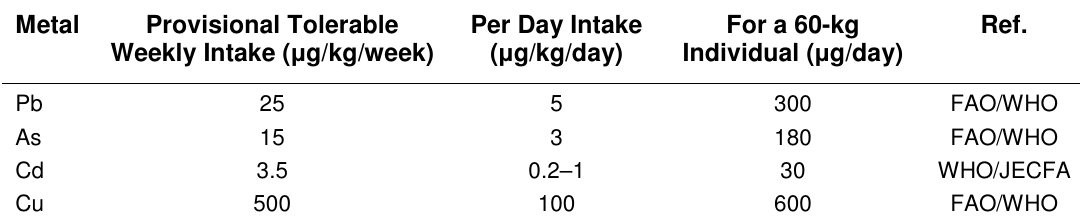
Permissible Intake Levels as per FAO/WHO